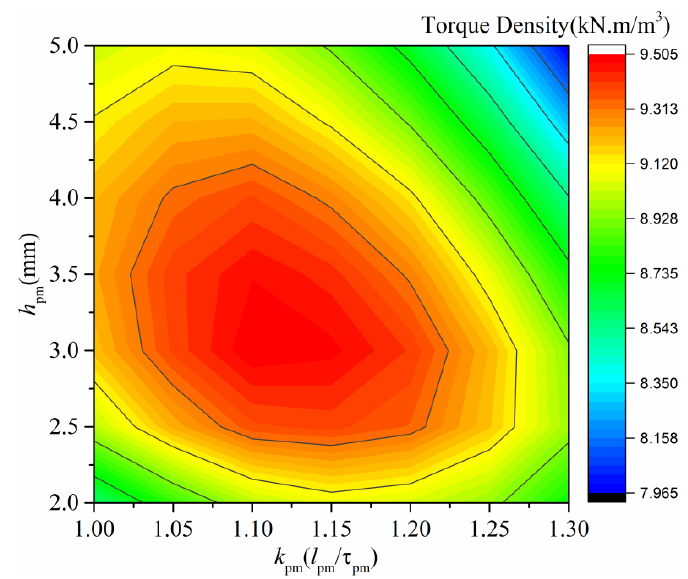
Figure 5. Influence of stator PM dimensions on torque density per volume.